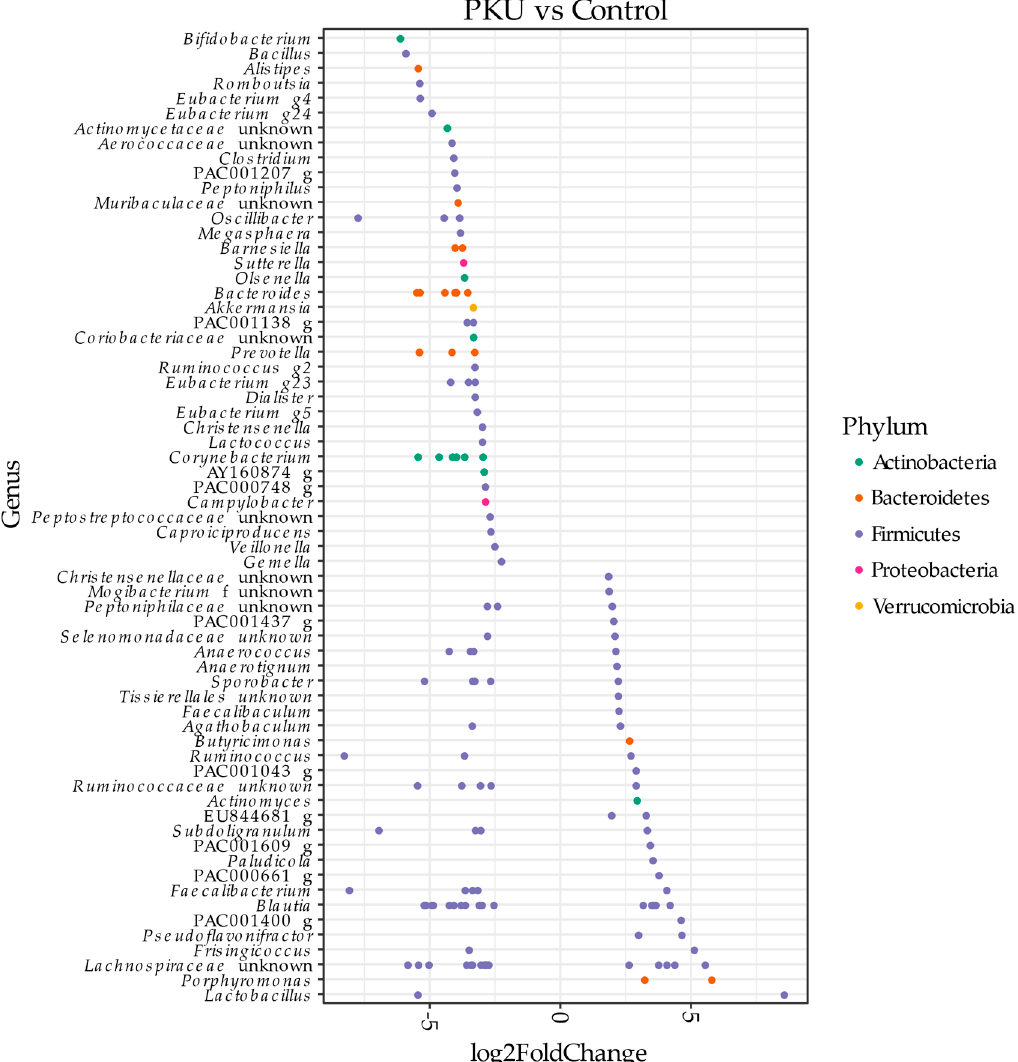
Figure 2. Pairwise comparison (DESeq2 analysis). Differentially abundant amplicon sequencing variants (ASVs) ( p < 0.001) in PKU patients and non-PKU control counterpart samples are shown. ASVs were assigned to the genus (y-axis) and phylum level (colors). Negative “log2FoldChange” values (x-axis) indicate higher abundance in PKU samples and positive values indicate higher abundances in control samples.